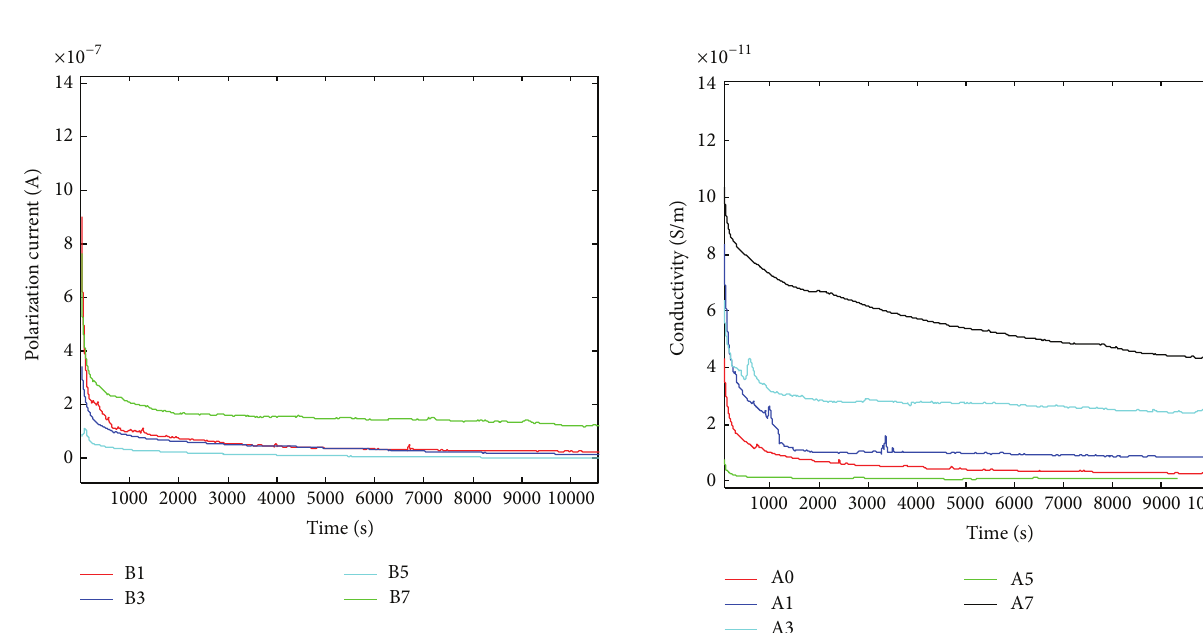
Figure 7: Polarization current values for samples B1, B3, B5, and B7.